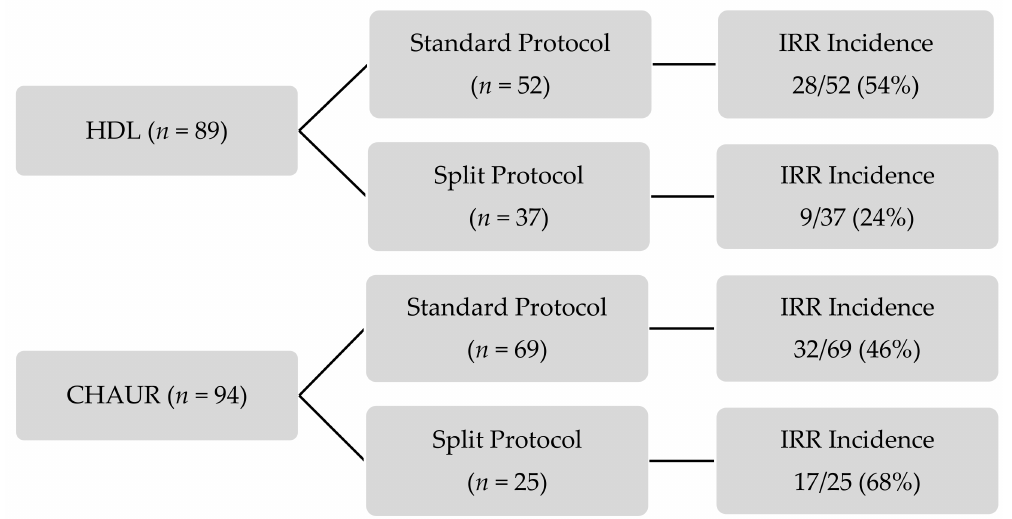
Figure 1. Incidence of infusion-related reactions in each group. CHAUR: Centre hospitalier affili é universitaire r é gional; HDL: H ô tel-Dieu de L é vis; IRR: infusion-related